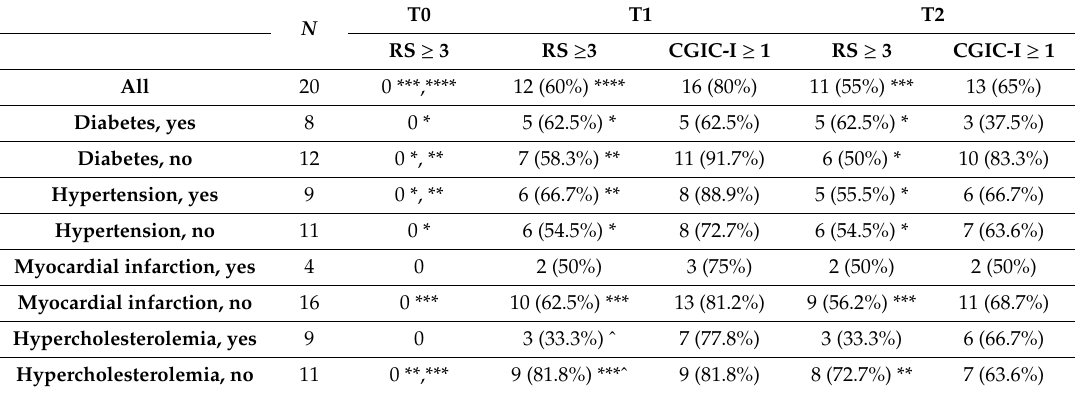
Table 2. Rigidity score (RS) and Clinical Global Impression of Change (CGIC-I) at baseline (T0), at the last LIESWT session (the sixth for patients who underwent six sessions, or the sixth and the twelfth for patients who underwent 12 sessions) (T1), and three months after the end of LIESWT sessions (T2) based on history of diabetes, hypertension, hypercholesterolemia, and myocardial